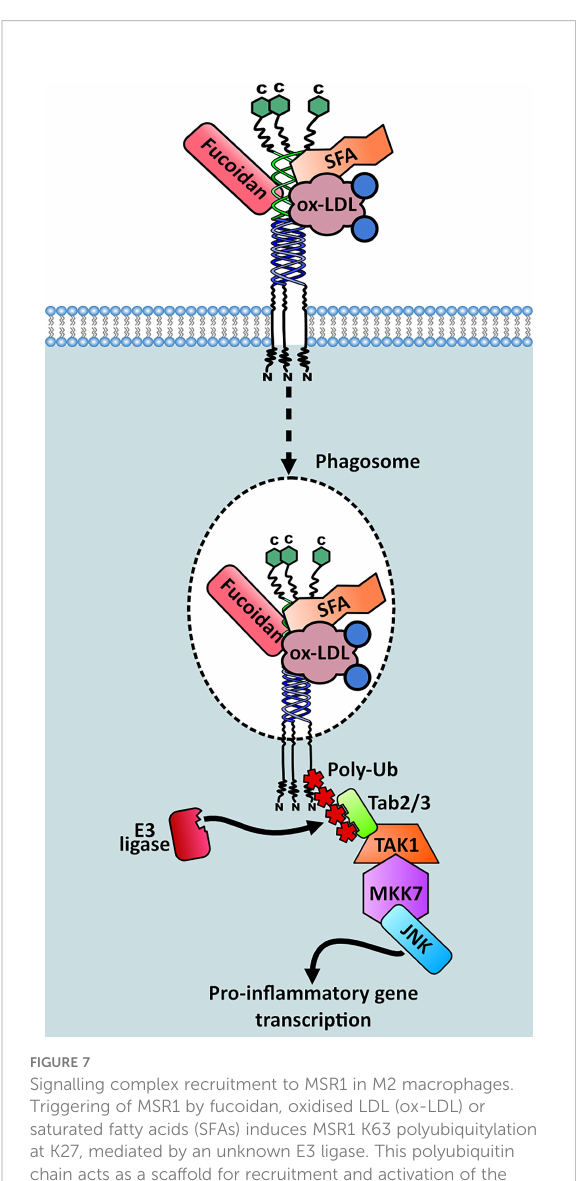
FIGURE 7 Signalling complex recruitment to MSR1 in M2